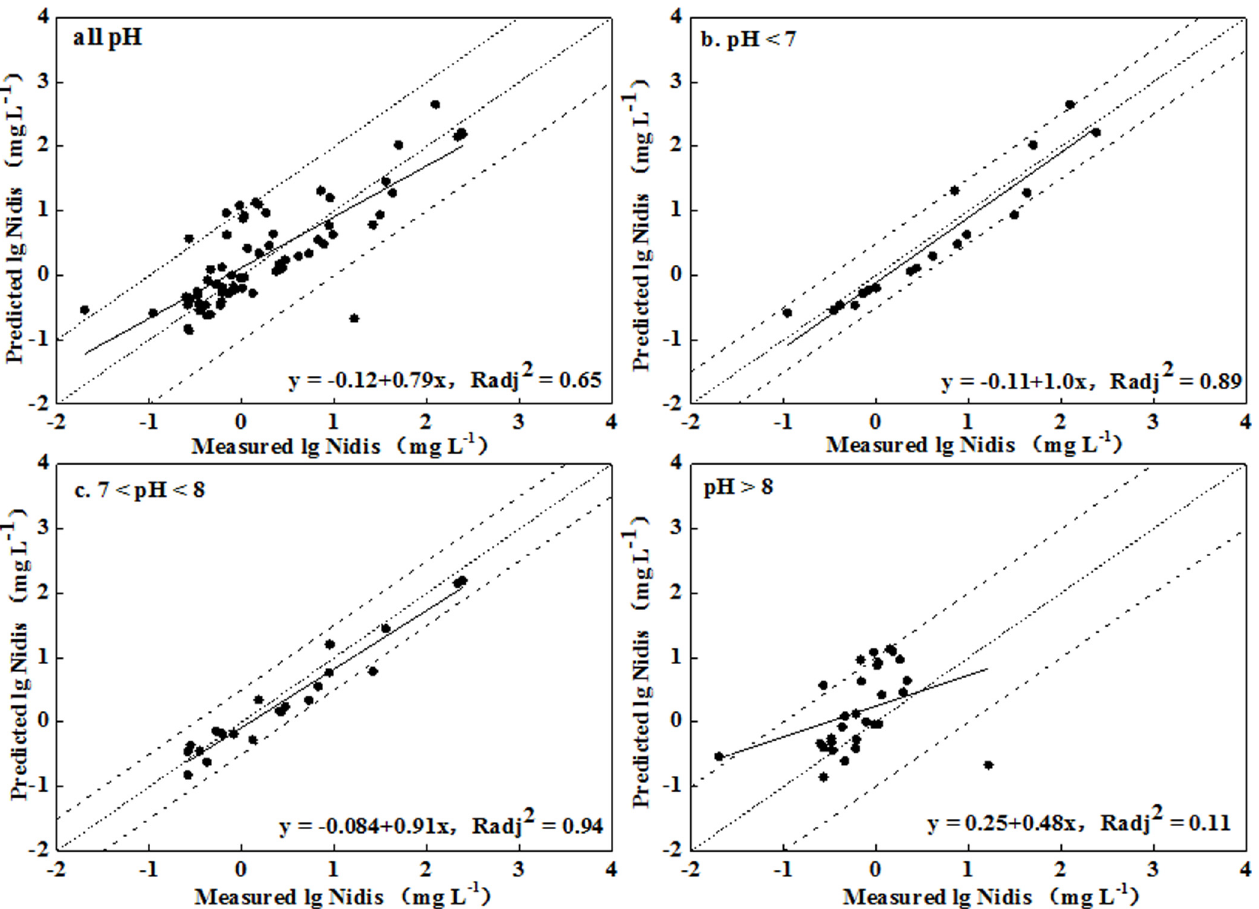
Fig 5. Measured soluble Ni concentration versus predicted Ni concentration using Visual MINTEQ in unleached soils (Ni dis represented the soluble Ni concentration in soil pore water).